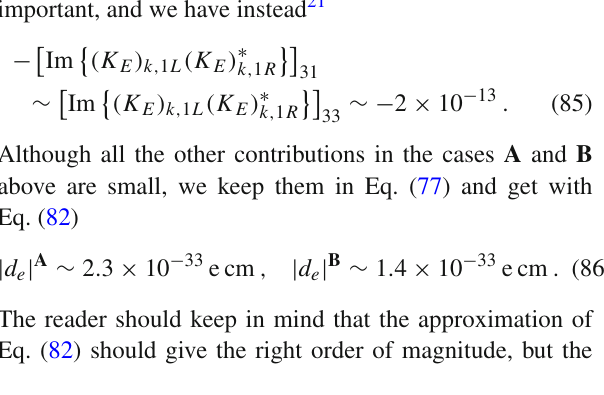
Fig. 7 As in Fig. 6, showing values of BR (μ → e γ) for the flavor choices A (left) and B (right) in model M3 with M in = 10 18 GeV, tan β = 7, λ (cid:8) = 0 . 00001 and λ = 0 . 6 (upper panels), and model